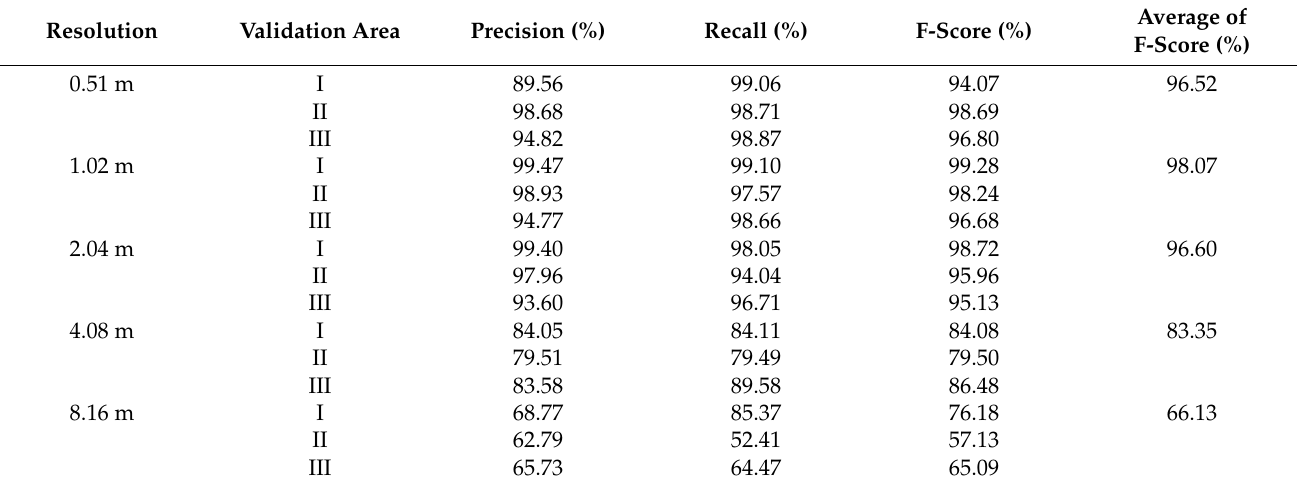
Figure 3. Area of gullies. ( a – c ) Area of gullies in validation areas I, II and III, respectively. Table 2. Accuracy evaluation of gullies’ interpretation.